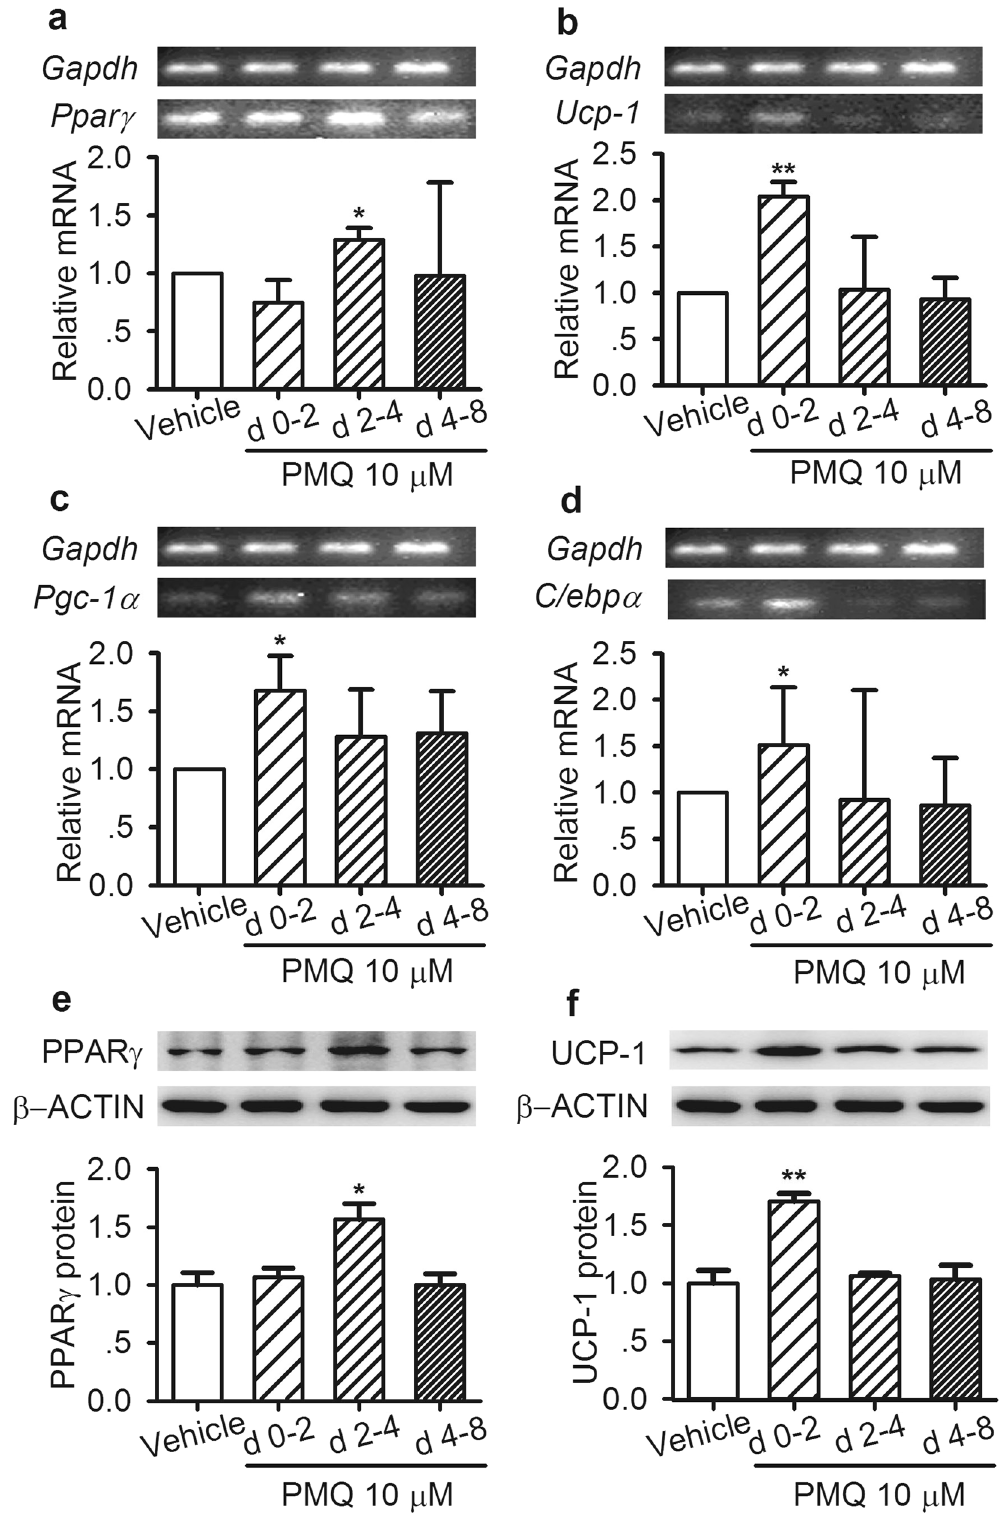
Figure 4. PMQ affected the expression of adipogenesis-related transcription factors and thermogenic-related genes in 3T3-L1 adipocytes during different differentiation stages. Cells were incubated with 10 μ M PMQ during the indicated periods, Days 0–2, 2–4 and 4–8. ( a–d ) On day 8, the relative mRNA levels of Ppar γ , Ucp-1 , Pgc-1 α and C/ebp α in 3T3-L1 adipocytes treated with or without PMQ. ( e,f ) On day 8, western blot analysis of PPAR γ and UCP-1 protein expression in 3T3-L1 adipocytes treated with the indicated agents. The gels or blots were cropped as indicated. The data are expressed as the mean ± SEM. n = 3 experiments; * p < 0.05, ** p < 0.01 vs